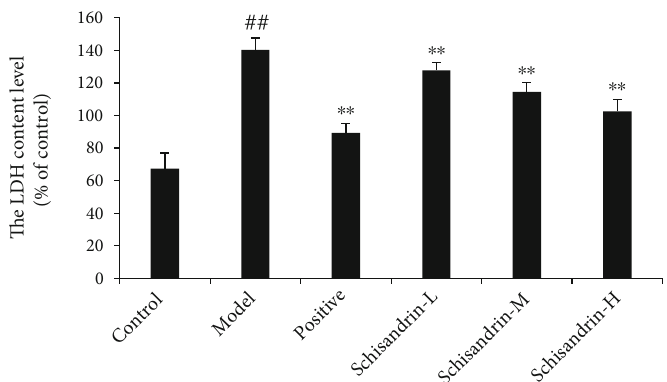
Figure 3: E ff ects of di ff erent concentrations of Schisandrin on CORT-induced LDH activity in cells. Cells were induced with CORT (250 μ mol/L) for 24h and subsequently treated with Schisandrin (0.1, 1, and 10 μ mol/L) or CORT (250 μ mol/L) for 24h. ## p < 0 : 01 , compared with the control group; ∗∗ p < 0 : 01 , compared with the model group.